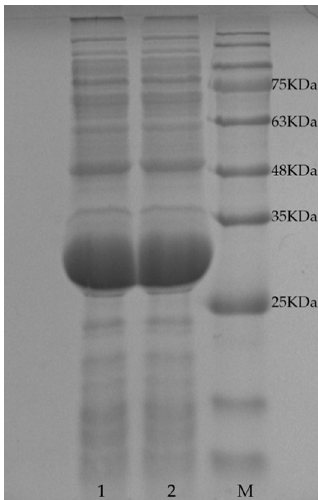
Figure 1. SDS–-PAGE results. The protein of about 30 kDa was the result of enzyme expression in E. coli . Lane1 and lane2, which have overexpression bands (target protein), are both protein electrophoresis bands of recombinant E. coli . Lane M is the marker.